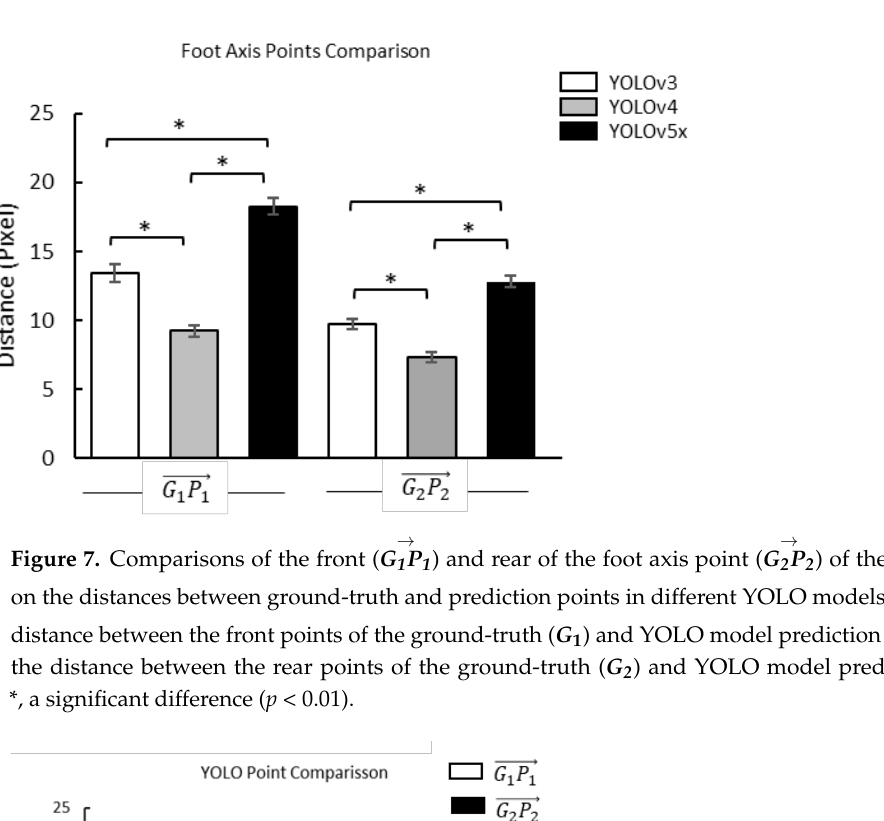
→ G 1 P 1 ), and rear points of the